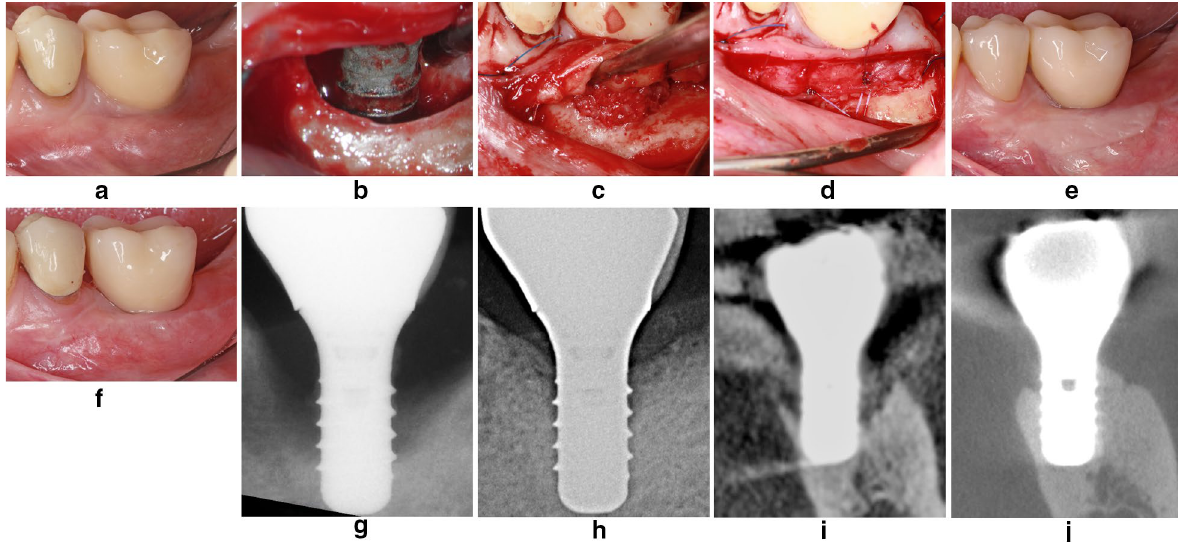
Fig. 3 a Severe peri‑implantitis lesion with suppuration and an insufficient width of the keratinized mucosa. b Implant surface decontamination with the Er:YAG laser. c Hard and soft tissue grafting according to the LAPIDER technique. d Periosteal suturing to cover the autogenous grafts. e Uneventful healing 9 months after LAPIDER surgery, but still without a sufficient zone of attached mucosa. f 3‑year follow‑up examination after an additional apically positioned flap with FGG. g Severe interproximal bone loss at pre‑operative examination. h Radiograph at 3‑year follow‑up examination reveals significant vertical bone regeneration. i Severe buccal and lingual bone loss at baseline. j CB‑CT at 3‑year follow‑up examination shows a pronounced buccal and lingual bone